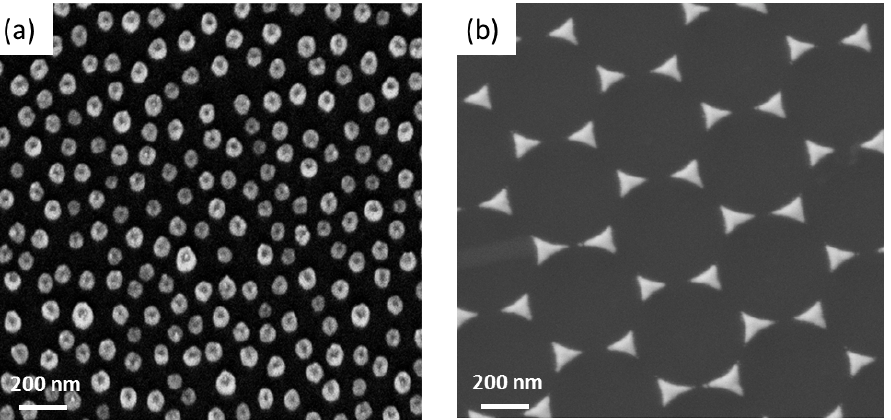
Figure 2. Top view SEM images of ( a ) gold nano-disks and ( b ) gold nano-prisms fabricated by NSL on glass substrate by using polystyrene (PS) nanospheres with diameters of 80 and 500 nm respec- tively.